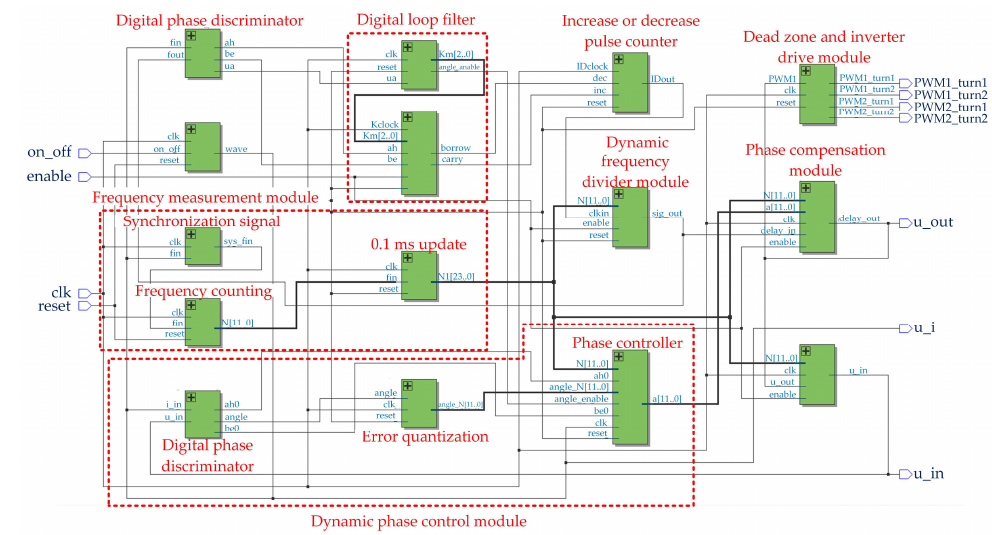
Figure 8. RTL top-level view of the frequency-tracking control system.